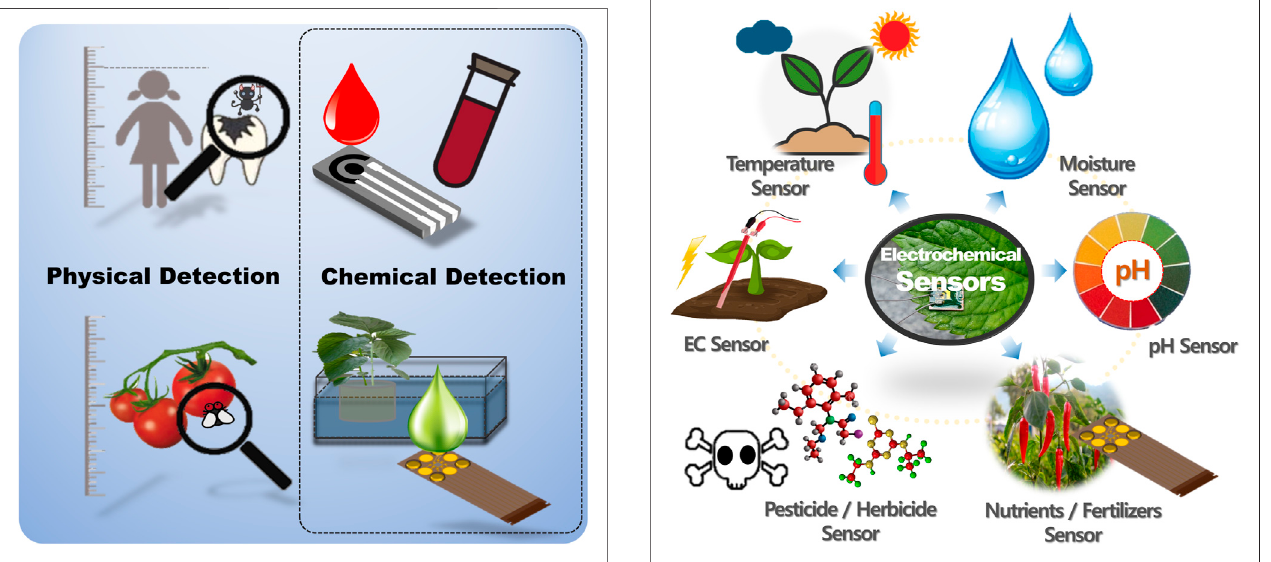
FIGURE 2 | The electrochemical sensor for monitoring plant health in precision